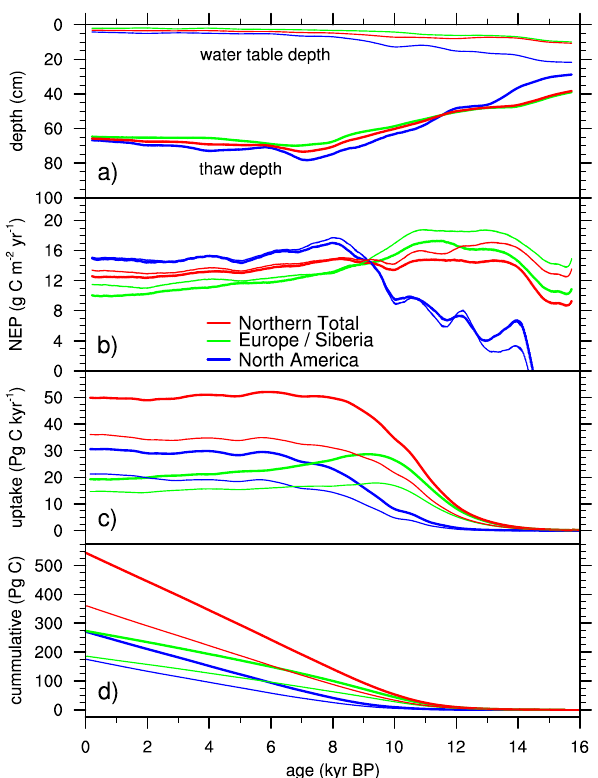
Fig. 9. (a) Changes in average water table and thaw depth below soil surface. (b) Evolution of area-weighted average NEP, (c) net north- ern peatland C uptake, and (d) cumulative peatland soil C since the late LGM for the two scenarios of peatland area expansion T09 (thin lines; Tarnocai et al., 2009) and Y10 (thick lines; Yu et al., 2010). Area-weighted averages and totals are calculated for Northern To- tal, Europe and Siberia, and North